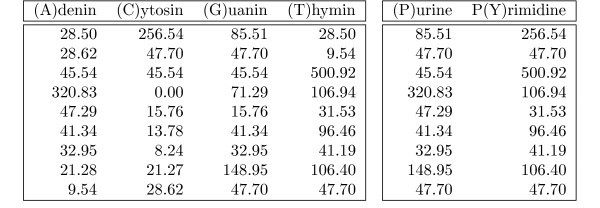
PSSM alphabet transformation. In the left PSSM M we used the normal four letter nucleotide alphabet A
 MathType@MTEF@5@5@+=feaafiart1ev1aaatCvAUfKttLearuWrP9MDH5MBPbIqV92AaeXatLxBI9gBamrtHrhAL1wy0L2yHvtyaeHbnfgDOvwBHrxAJfwnaebbnrfifHhDYfgasaacH8akY=wiFfYdH8Gipec8Eeeu0xXdbba9frFj0=OqFfea0dXdd9vqai=hGuQ8kuc9pgc9s8qqaq=dirpe0xb9q8qiLsFr0=vr0=vr0dc8meaabaqaciaacaGaaeqabaWaaeGaeaaakeaaimaacqWFaeFqaaa@3821@ = {A, C, G, T} to describe a transcription factor binding site found in Hox A3 gene promoters. In the right PSSM M_
 MathType@MTEF@5@5@+=feaafiart1ev1aaatCvAUfKttLearuWrP9MDH5MBPbIqV92AaeXatLxBI9gBaebbnrfifHhDYfgasaacH8akY=wiFfYdH8Gipec8Eeeu0xXdbba9frFj0=OqFfea0dXdd9vqai=hGuQ8kuc9pgc9s8qqaq=dirpe0xb9q8qiLsFr0=vr0=vr0dc8meaabaqaciaacaGaaeqabaqabeGadaaakeaadaqiaaqaaiabd2eanbGaayPadaaaaa@2E91@ we used a reduced two letter alphabet A_
 MathType@MTEF@5@5@+=feaafiart1ev1aaatCvAUfKttLearuWrP9MDH5MBPbIqV92AaeXatLxBI9gBamrtHrhAL1wy0L2yHvtyaeHbnfgDOvwBHrxAJfwnaebbnrfifHhDYfgasaacH8akY=wiFfYdH8Gipec8Eeeu0xXdbba9frFj0=OqFfea0dXdd9vqai=hGuQ8kuc9pgc9s8qqaq=dirpe0xb9q8qiLsFr0=vr0=vr0dc8meaabaqaciaacaGaaeqabaWaaeGaeaaakeaadaqiaaqaaGWaaiab=bq8bbGaayPadaaaaa@38E3@ = {P, Y} that differs only between purine (adenine or guanine) and pyrimidine (cytosine or thymine) nucleotides. Hence we have two character classes: Φ-1(P) = {A, G} and Φ-1(Y) = {C, T}. Consequently M_
 MathType@MTEF@5@5@+=feaafiart1ev1aaatCvAUfKttLearuWrP9MDH5MBPbIqV92AaeXatLxBI9gBaebbnrfifHhDYfgasaacH8akY=wiFfYdH8Gipec8Eeeu0xXdbba9frFj0=OqFfea0dXdd9vqai=hGuQ8kuc9pgc9s8qqaq=dirpe0xb9q8qiLsFr0=vr0=vr0dc8meaabaqaciaacaGaaeqabaqabeGadaaakeaadaqiaaqaaiabd2eanbGaayPadaaaaa@2E91@(i, P) = max{M(i, a) | a ∈ {A, G}} and M_
 MathType@MTEF@5@5@+=feaafiart1ev1aaatCvAUfKttLearuWrP9MDH5MBPbIqV92AaeXatLxBI9gBaebbnrfifHhDYfgasaacH8akY=wiFfYdH8Gipec8Eeeu0xXdbba9frFj0=OqFfea0dXdd9vqai=hGuQ8kuc9pgc9s8qqaq=dirpe0xb9q8qiLsFr0=vr0=vr0dc8meaabaqaciaacaGaaeqabaqabeGadaaakeaadaqiaaqaaiabd2eanbGaayPadaaaaa@2E91@(i, Y) = max{M(i, a) | a ∈ {C, T}} ∀i ∈ [0, 8]